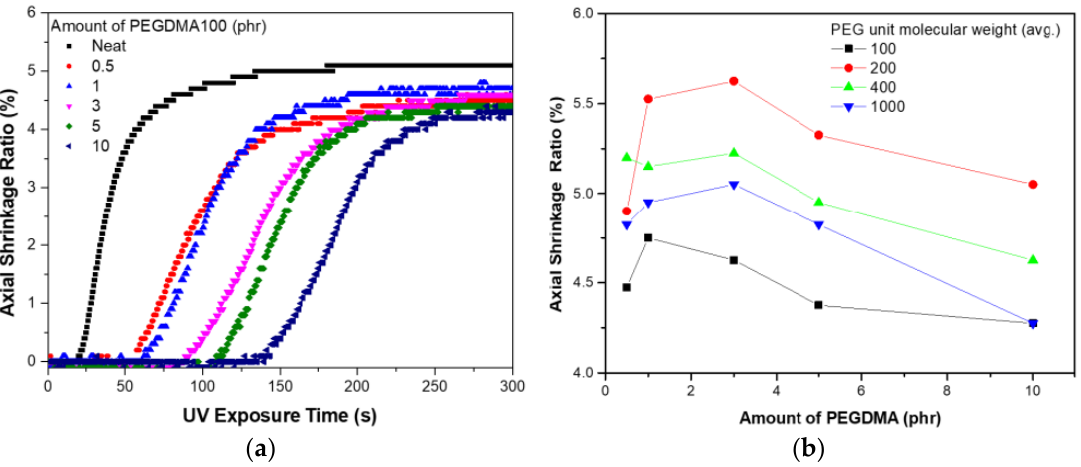
Figure 9. Shrinkage ratio of a UV-curable system ( a ) when using PEGDMA100 and ( b ) for different PEGDMA sizes.